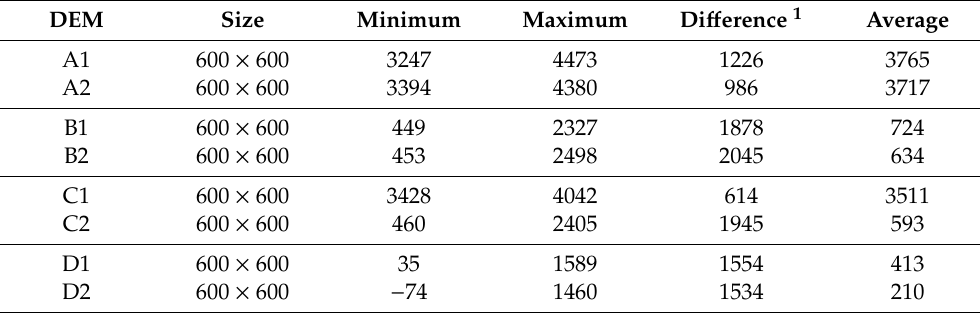
Table 3. Statistics of the digital elevation models (DEMs) for experiments.